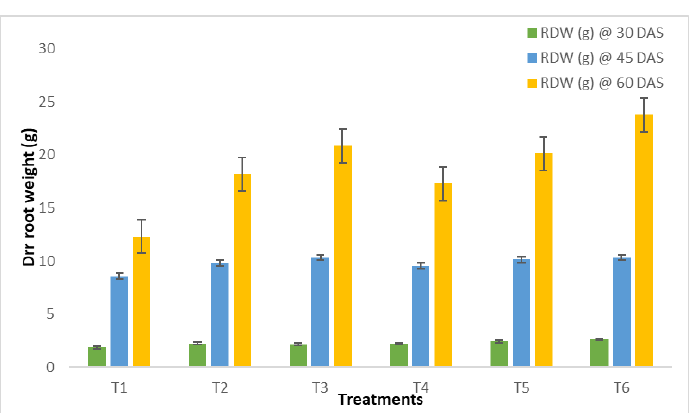
Figure 6. Effects of NPK consortia biofertilizer and chemical fertilizers on mean of root dry weight at different growth stages; RDW = Dry Root Weight, DAS = Days after sowing